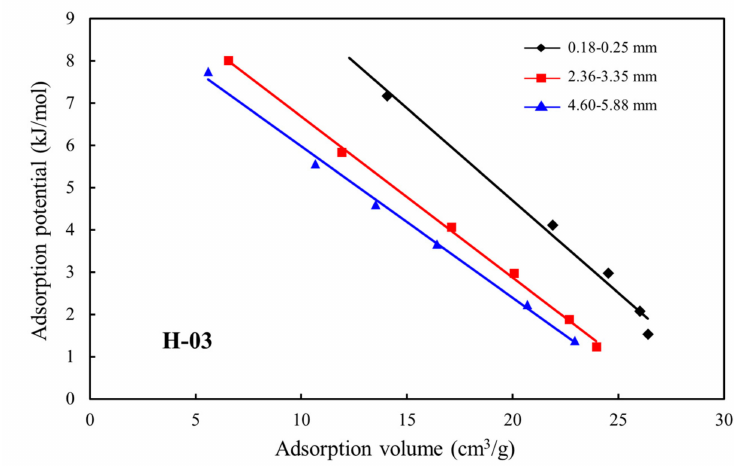
Figure 14. Isothermal adsorption curves of di ff erent particle